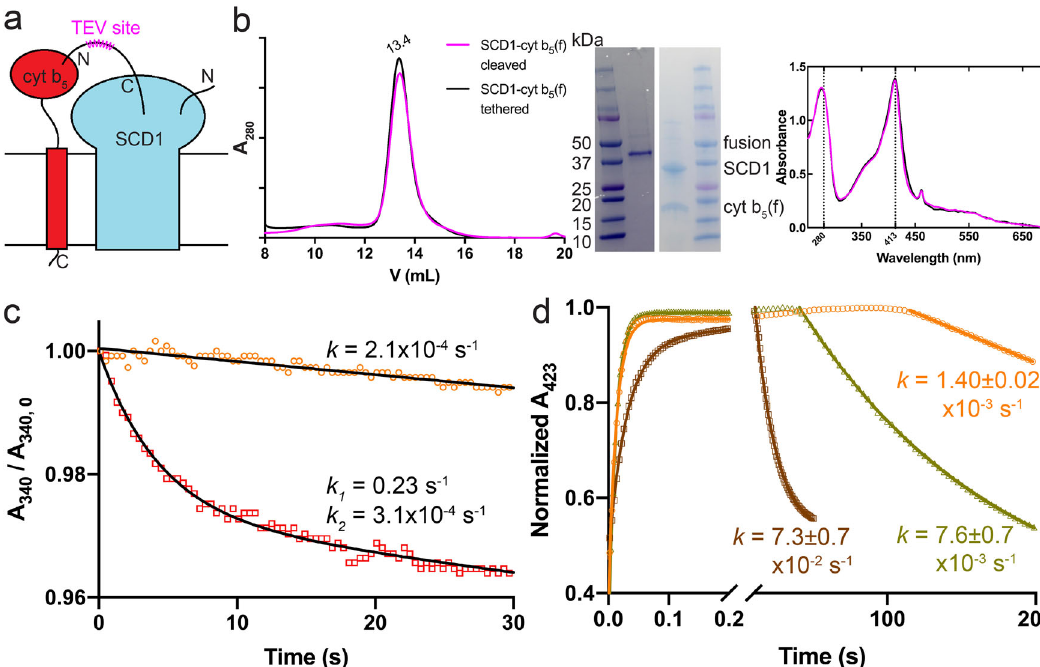
Fig. 4 SCD1 and full-length cyt b5 can form a stable complex with faster electron transfer kinetics. a Schematic diagram of SCD1-cyt b 5 fusion constructs. b SEC pro fi le (left), SDS-PAGE image (inset), and UV-Vis spectra (right) of the linker-cleaved (magenta) and tethered (black) fusion of SCD1- cyt b 5 . Almost identical SEC pro fi le and optical spectra suggest the stable assembly between SCD1 and cyt b 5 . c Biphasic kinetics of NADH consumption by b 5 R with SCD1-cyt b 5 fusion in the presence of substrate stearoyl-CoA (red) compared to the slow linear decrease of NADH in the absence of substrate (orange). The absorbance of NADH at 340 nm (A 340 ) was measured and the y axis is the normalized A 340 against the initial values (A 340, 0 ). Excess NADH was used in the measurements. d The accelerated electron transfer between reduced cyt b 5 and SCD1 in the SCD1-cyt b 5 complex (brown) compared to that between the individual cyt b 5 and SCD1 (yellow) and auto-oxidation of cyt b 5 (orange). The Soret absorbance of reduced cyt b 5 at 423 nm was monitored. One molar equivalent of NADH was added, which resulted in the initial rising phases of the fast electron transfer to cyt b 5 via b 5 R. Rate constants ( k ) are denoted as mean ± SEM calculated from three independent repeats ( n =